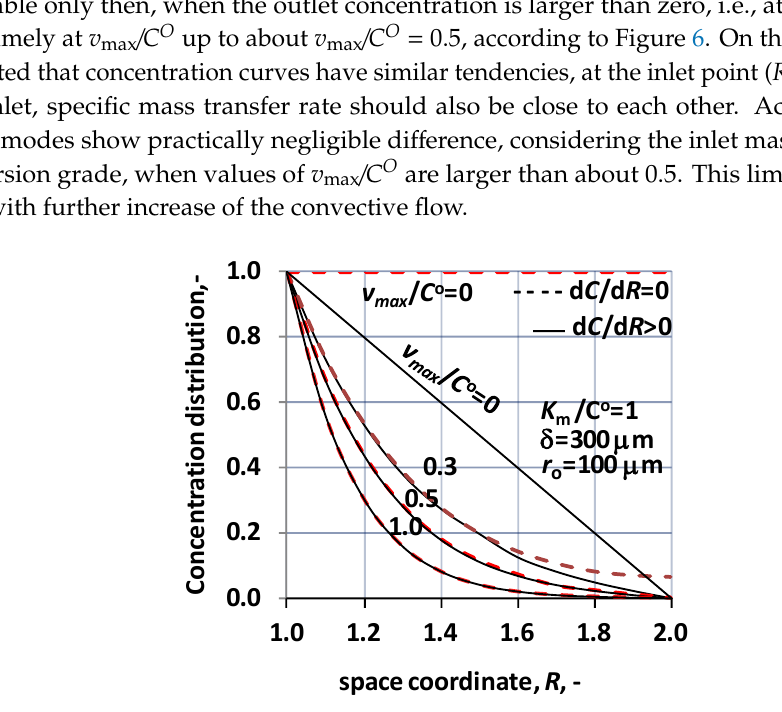
Figure 6. Concentration distribution as a function of space coordinate, applying the two operating modes, i.e., transport without sweeping phase (broken lines) and transport with sweeping phase (continuous lines). (( N = 1000); δ = 300 µ m r o = 100 µ m; K M / C O = 1; D = 1.9 × 10 − 9 m 2 / s; Pe o = 2).